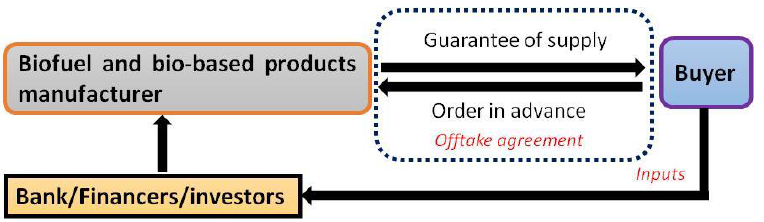
Figure 20. A pictorial representation of the off-take process of biofuels and bio-based products.